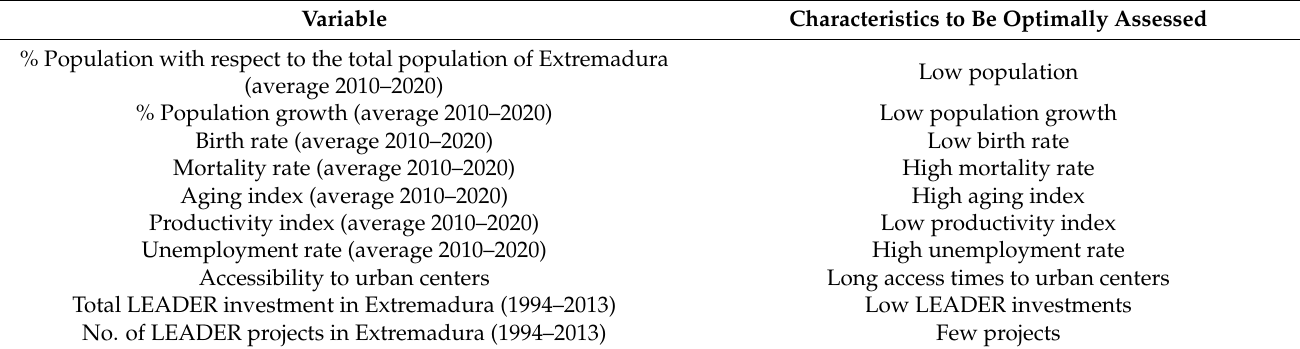
Figure 3. Methodological process. Source: Authors. Table 1. Selected variables and characteristic to be optimally